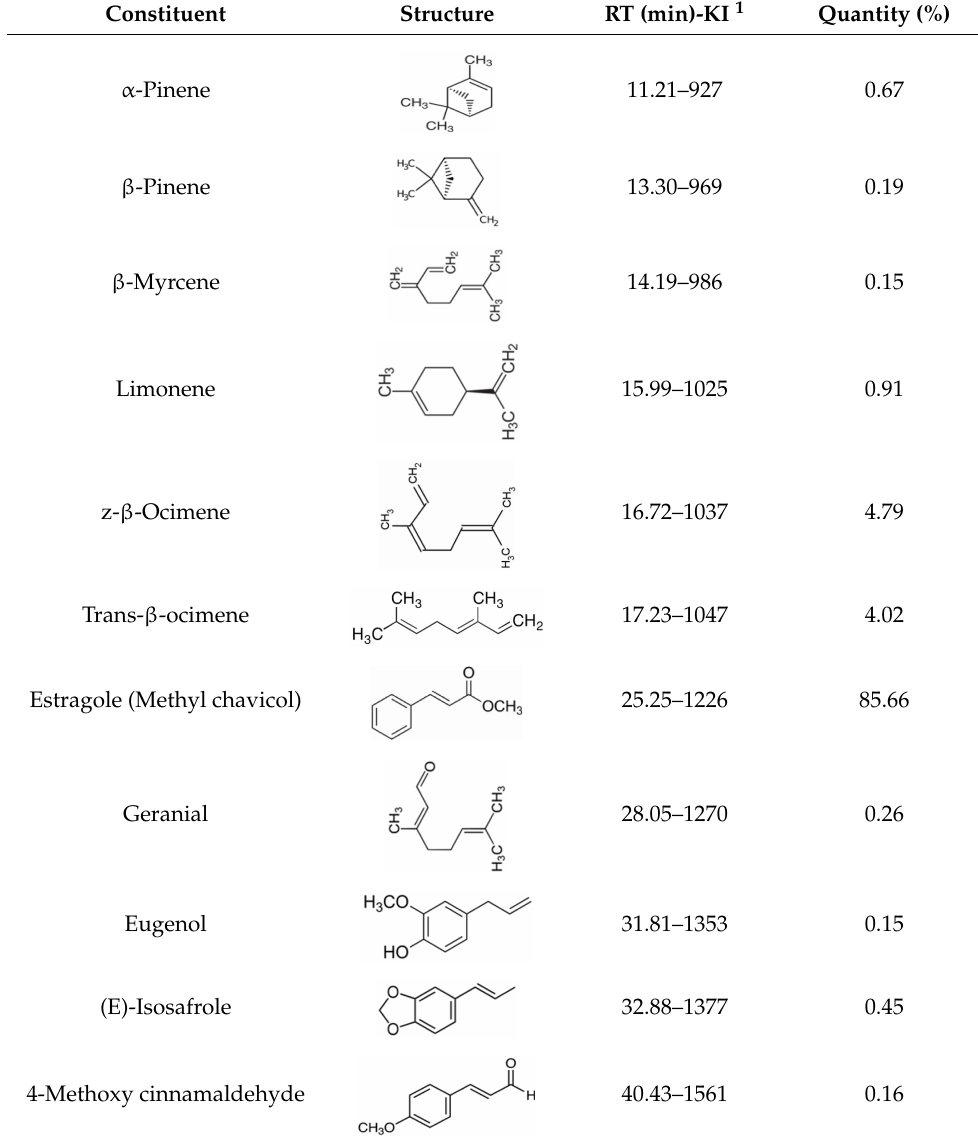
Table 1. Major chemical constituents of TEO analyzed by